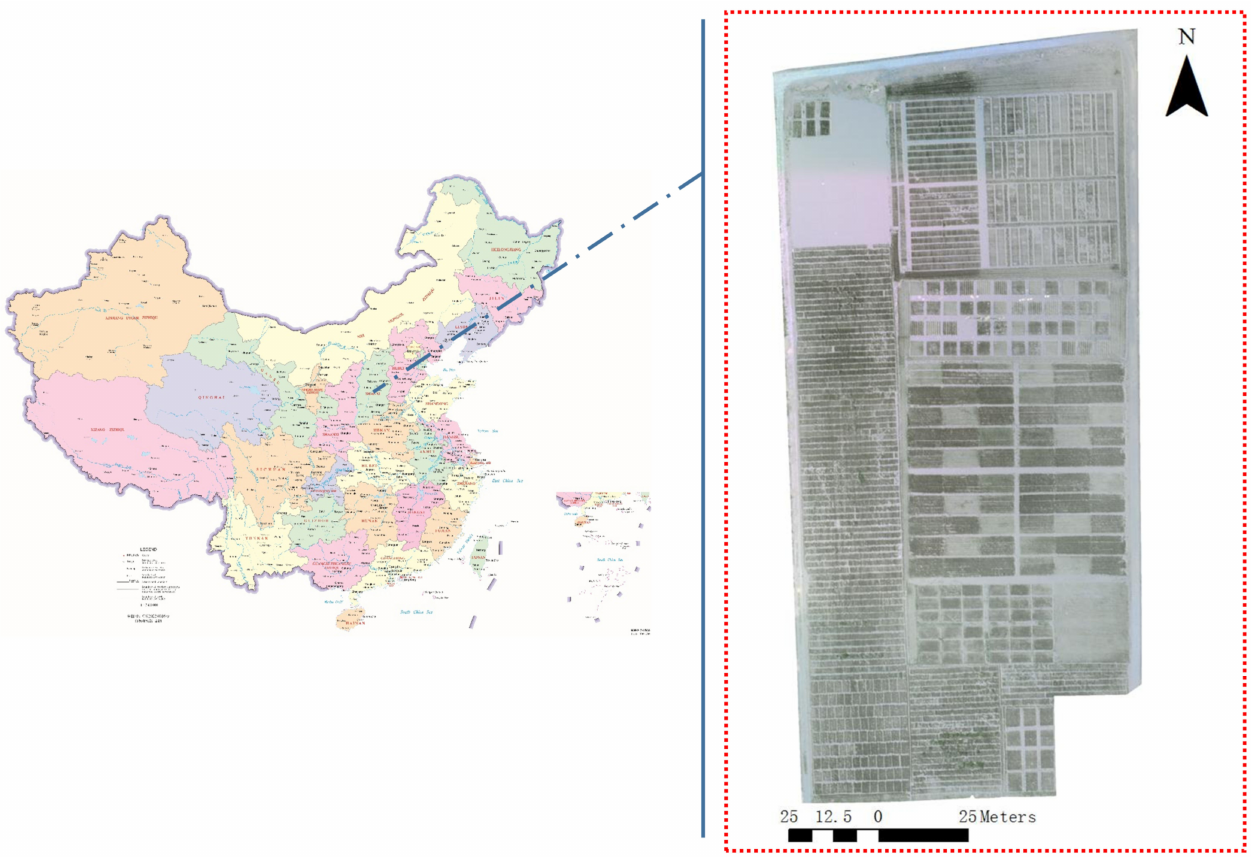
Figure 2. Multi-variety wheat planting area, Institute of Water-saving Agriculture in Arid Areas of China (IWSA), Northwest A&F